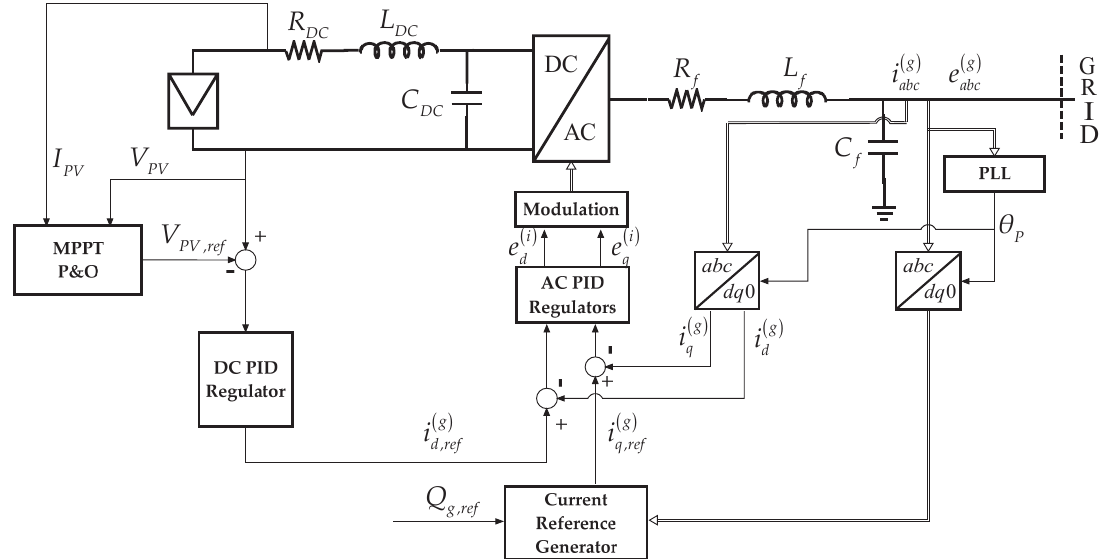
Figure 2. Conventional control system scheme referring to a single line diagram.